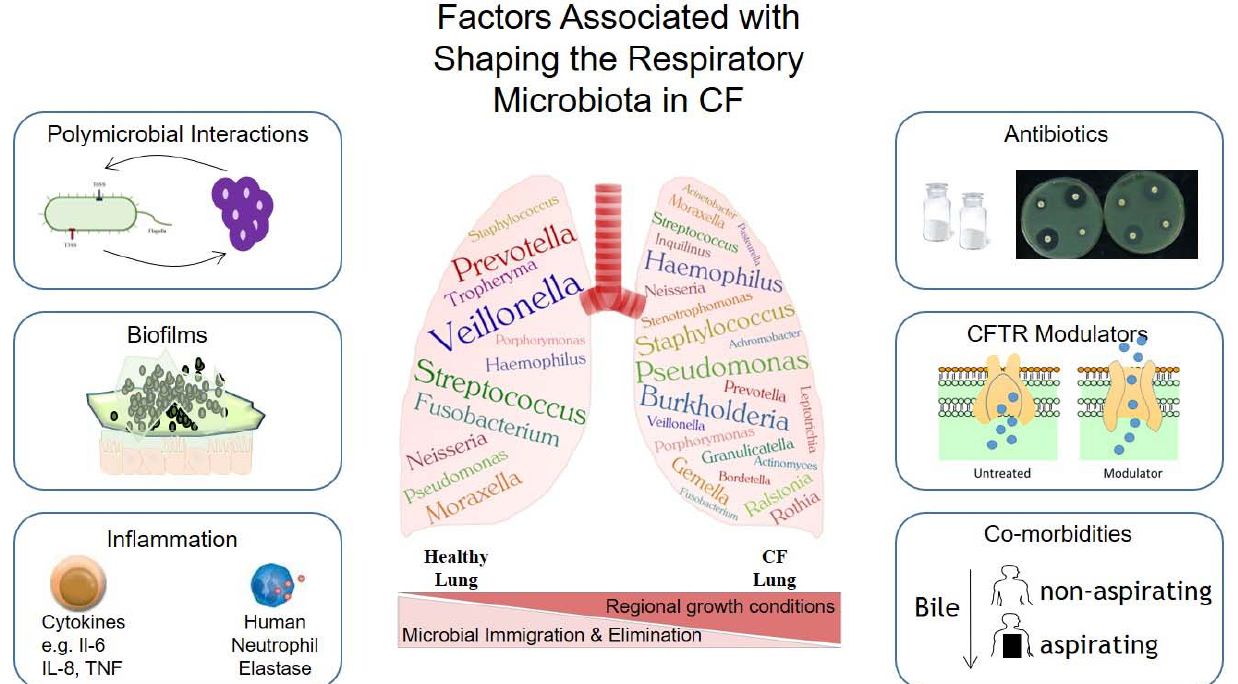
Figure 1. Summary of common microbiota associated with healthy vs. CF lungs. Commonly identified taxa are illustrated and the factors governing the dynamics of these communities are presented. Microbes, such as the anaerobes Veillonella and Prevotella , are routinely isolated from healthy lungs. While Staphylococcus and Haemophilus are known to be early colonisers of the lungs of paediatric patients with CF, Pseudomonas ultimately achieves a dominant position within the lung microbiota. The balance between microbial immigration and elimination has been described as a primary influence on the community structure of a healthy lung. In contrast, regional growth conditions within the lung microenvironment have been shown to drive population diversification. Summarized in the figure are factors that shape, model and remodel the lung microbiota. These include polymicrobial interactions which can influence the survival and infection acquisition, biofilm development that can increase the persistence of infections, inflammatory responses that can both directly and indirectly affect the bacteria within the lung, antibiotic use which can directly alter the lung microbiota as well as causing alterations in inflammation and the gut microbiome, CFTR modulators which can increase airway clearance and co ‐ mor ‐ bidities that can influence the lung microbiome directly and through interconnections such as the gut–lung axis.